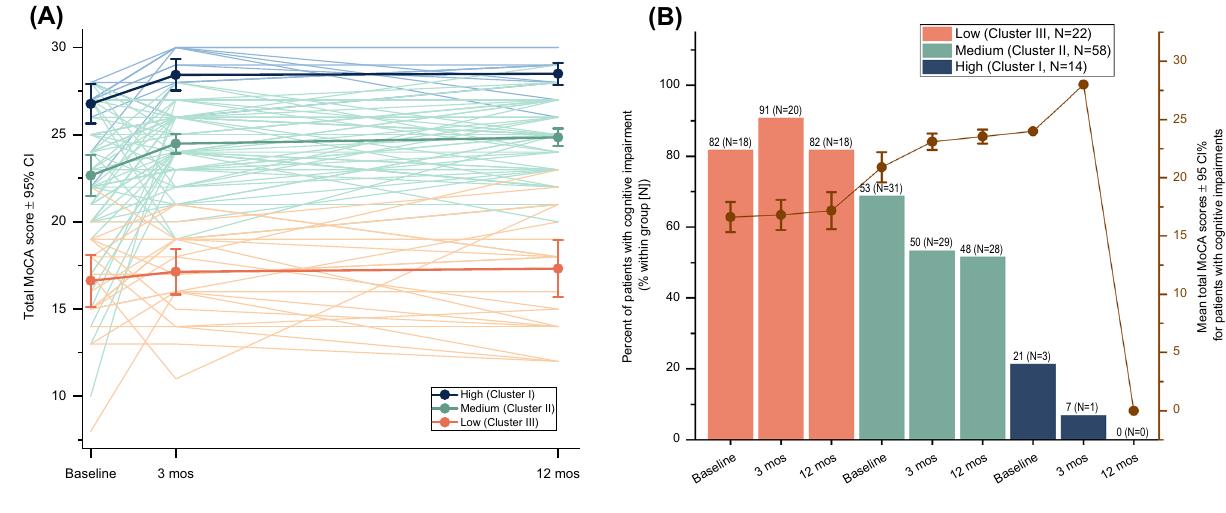
Figure 2. (A) Individual changes in total MoCA score over time in the different cognitive functioning groups (high, medium and low) and mean total MoCA scores of each cognitive functioning group are shown. (B) Percent of patients with cognitive impairment within each cognitive functioning group after age, sex and education-matching with the Swedish population. The light brown line represents the mean total MoCA of patients with cognitive impairment for each group. MoCA Montreal Cognitive Assessment, CI confidence interval, mos months.